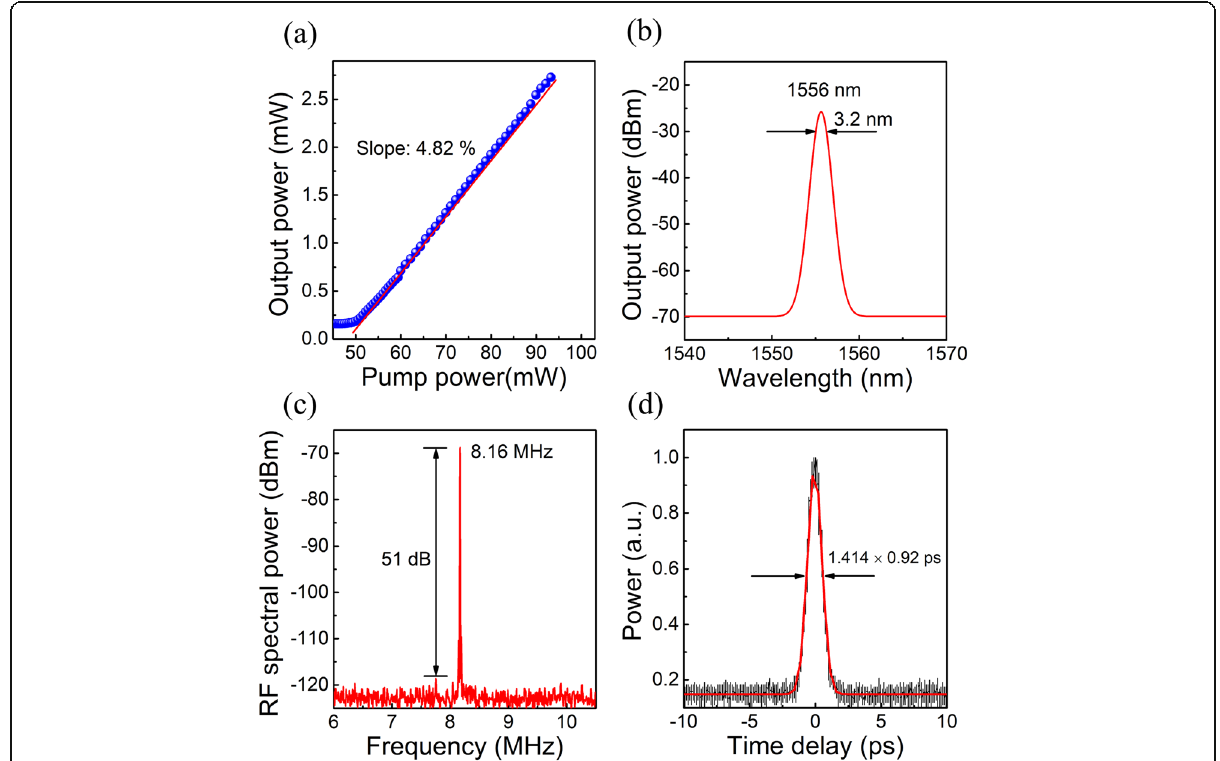
Fig. 5 Characteristics of mode-locked the developed fiber laser. a Output power versus pump power. b Output optical spectra. c RF spectrum of the mode-locked fiber laser. d Autocorrelation